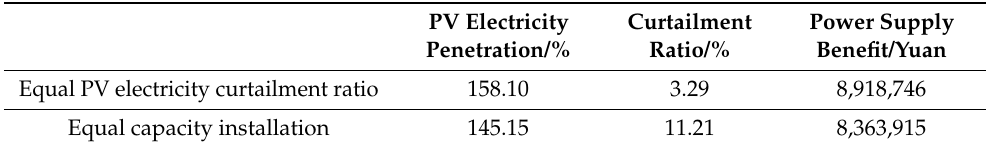
Table 2. Result comparison of different allocation